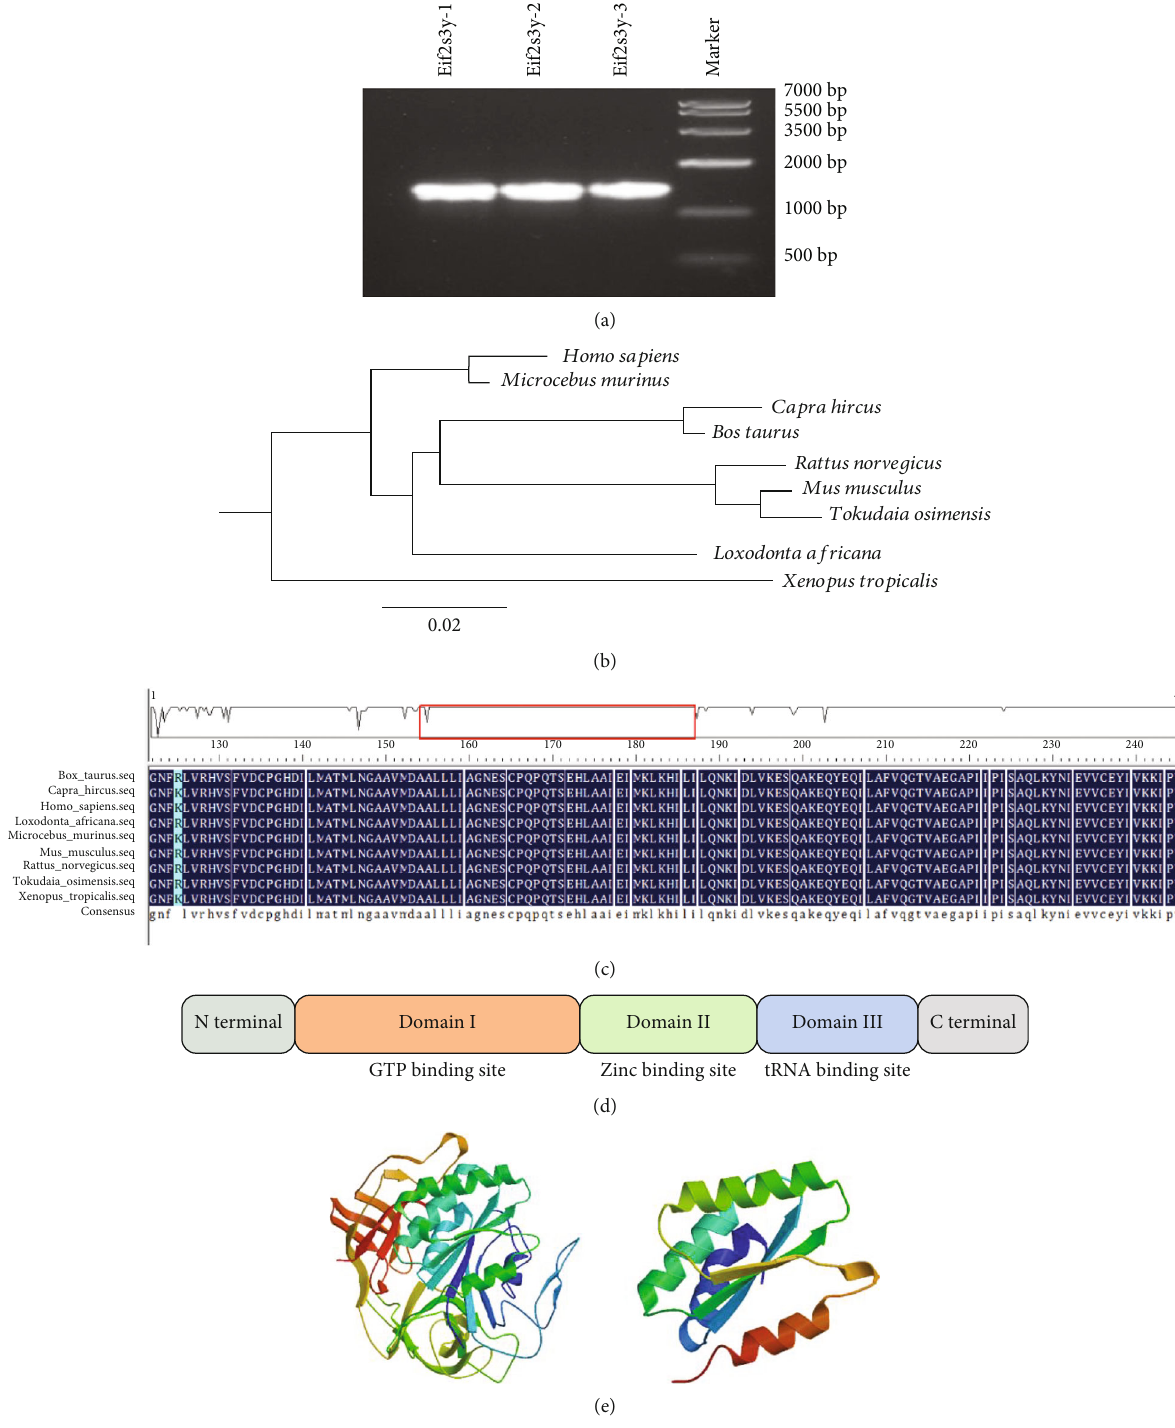
Figure 2: Structure and bioinformatics analysis of Eif2s3y . (a) PCR analysis of Eif2s3y in dairy goat testes. Three independent duplications all had the same size of 1413bp. (b) Eif2s3y phylogenetic tree in di ff erent species constructed by MEGA 4.1 software. (c) Eif2s3y amino acid sequence alignment of di ff erent species analyzed by DNAMAN software. (d) Conserved domains of Capra hircus Eif2s3y CDS were predicted by NCBI CD-Search. Some important structures were found in conserved domains. (e) Eif2 γ protein structural pattern (up) and four zinc fi nger domains (down) analyzed by the SWISS-MODEL Workspace